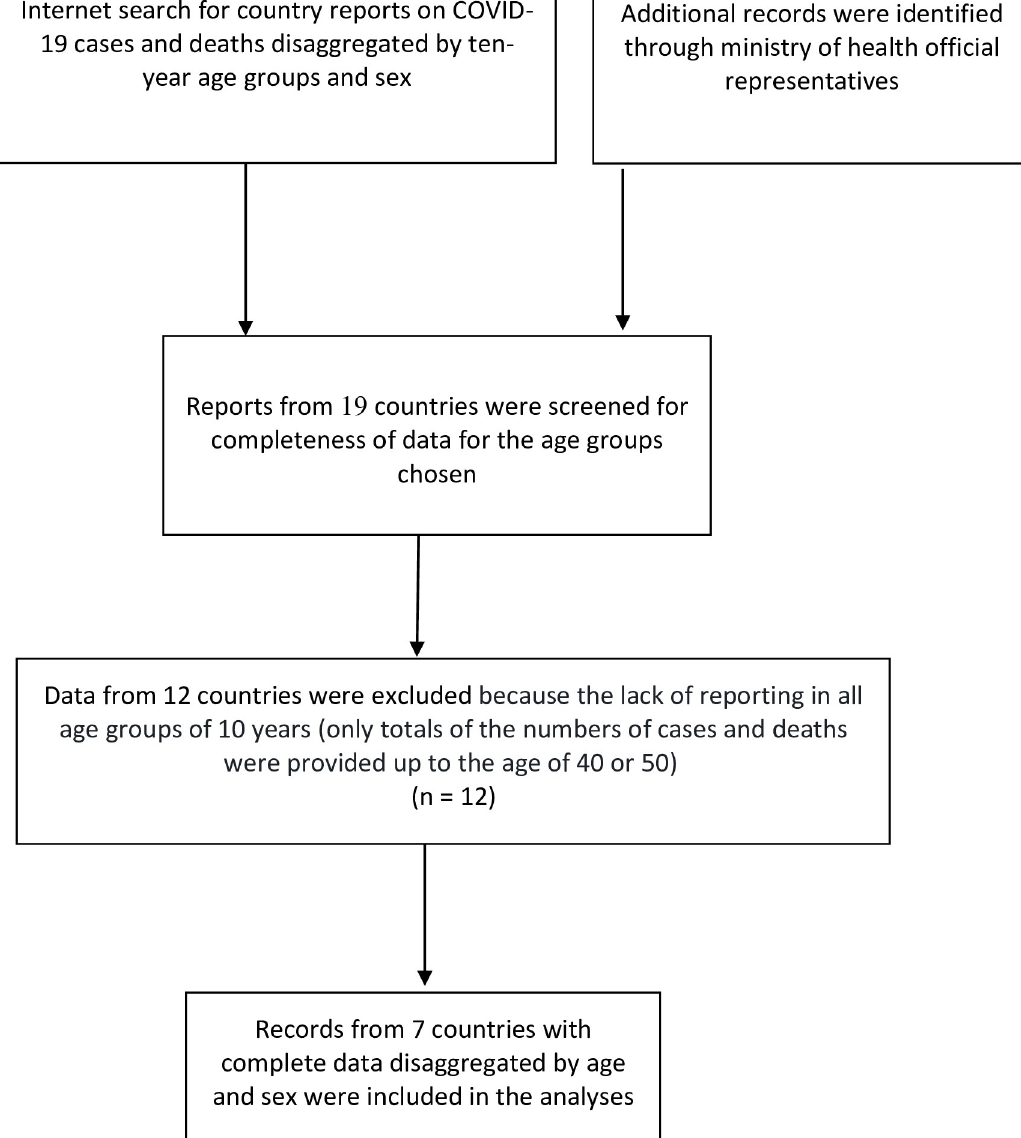
Fig 1. PRISMA flowchart describing the included and excluded